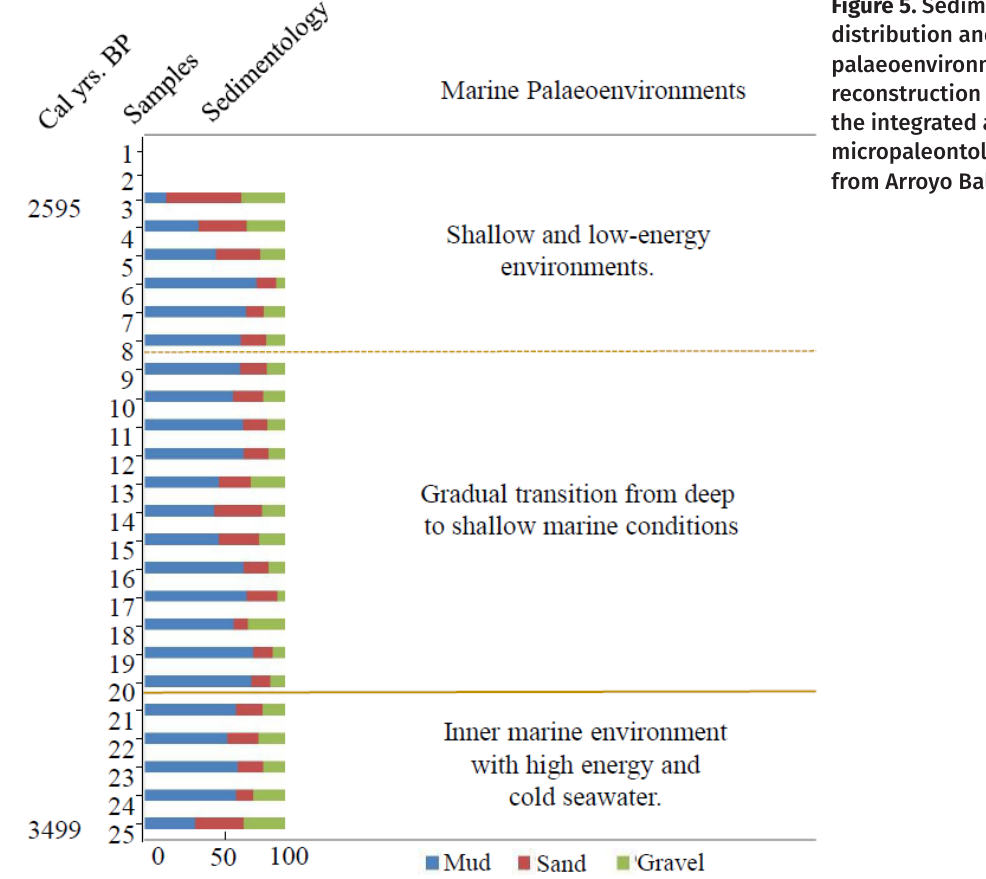
Figure 5. Sedimentological distribution and palaeoenvironmental reconstruction based on the integrated analysis of micropaleontological data from Arroyo